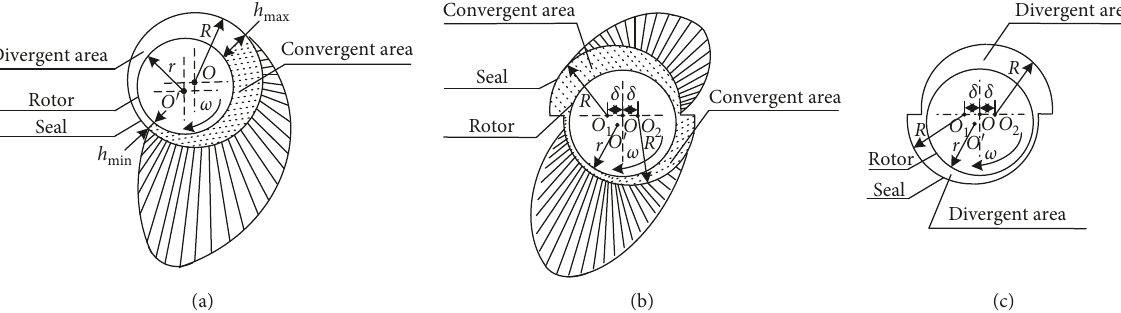
Figure 1: Schematics of the hydrodynamic pressure effects of cylinder seal and dislocated seals. (a) Cylinder seal. (b) Positive dislocated seal. (c) Negative dislocated seal.